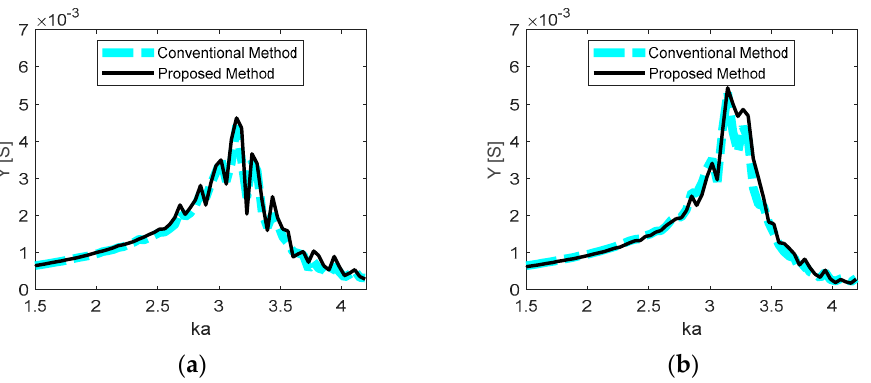
Figure 9. Electrical admittance of transducer #9 calculated by the proposed method (solid line) and the conventional FEM (thick dashed line) when ( a ) θ = 0 ◦ and ( b ) θ = 30 ◦ .